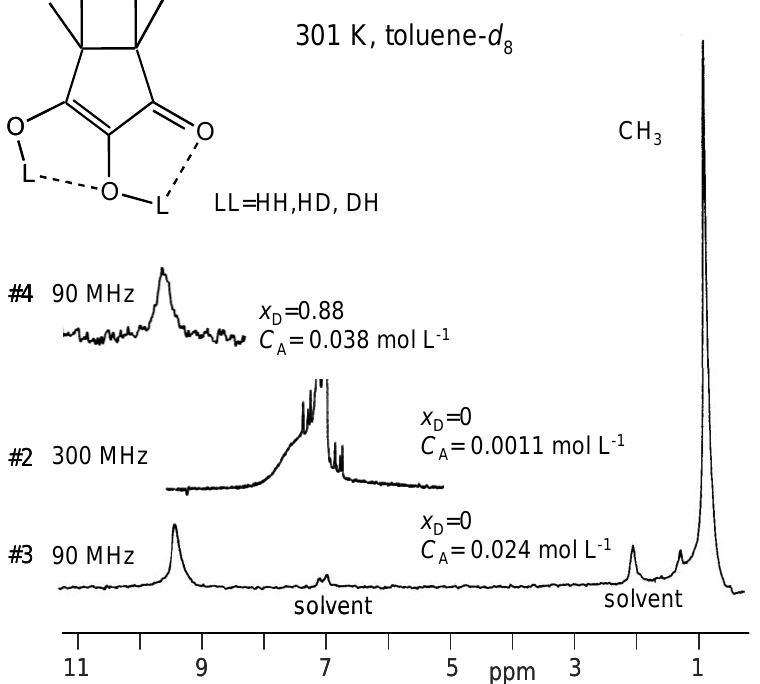
Figure 7. 1 H NMR spectra of TMRA at 301 K dissolved in toluene- d 8 at different concentrations. The concentration of sample #3 was determined as shown in Section 3.2.